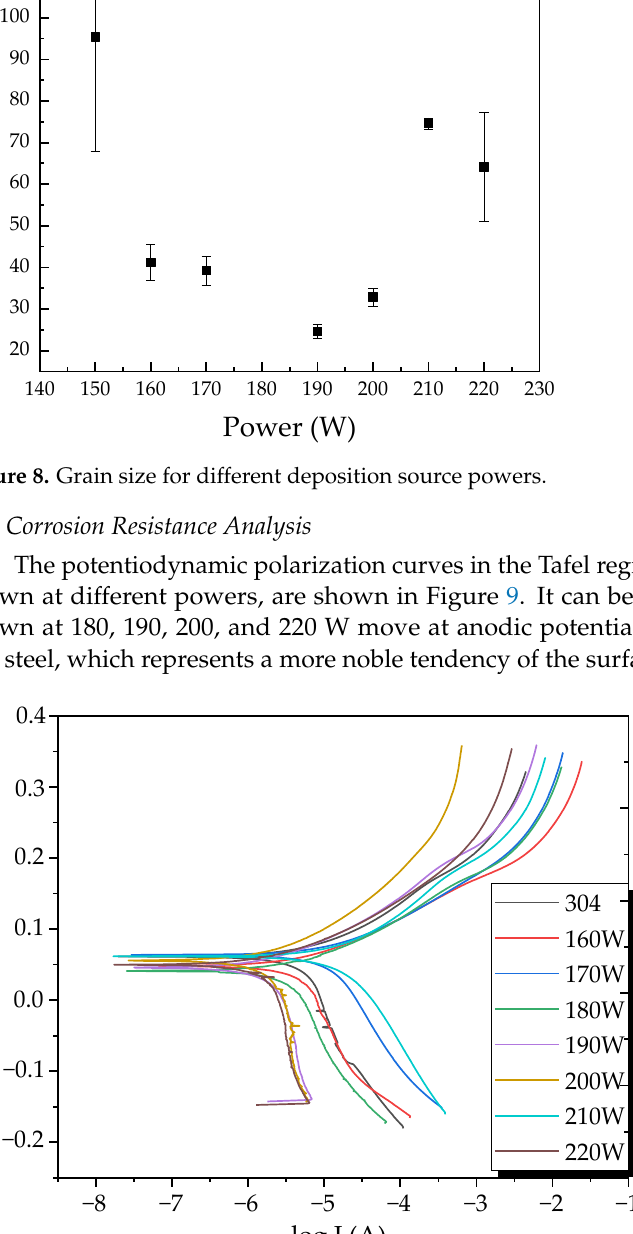
corrosion current (Icorr), corrosion potential (Ecorr), polarization resistance (Rp), and